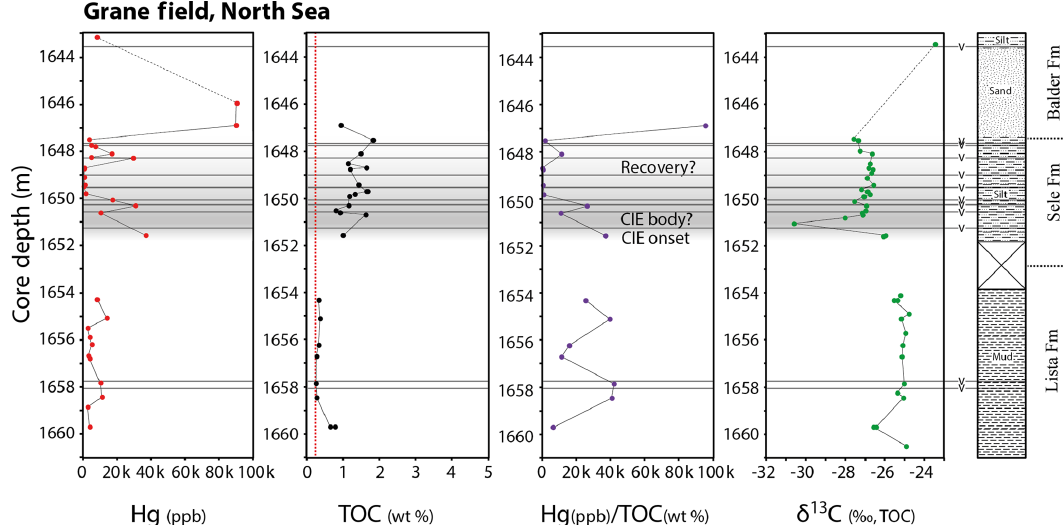
Figure 3. Mercury (Hg), total organic carbon (TOC), Hg / TOC, and δ 13 C TOC data from sections of core 25/11-17 from the Grane field in the Norwegian North Sea. Mercury concentrations (ppb) are shown in red, total organic carbon (TOC) concentrations (wt%) in black, Hg / TOC ratios in purple, and δ 13 C values in green. The stratigraphic log is adapted from Haaland et al. (2000). Incomplete core recovery is marked by crossed squares. The grey shaded area shows the approximate onset, body, and recovery phases of the carbon isotope excursion (CIE). Identified tephra layers are shown as dark grey bands across the figure. The red dashed line in the TOC graph denotes the recommended threshold for TOC concentrations to report Hg / TOC values (Grasby et al., 2016).